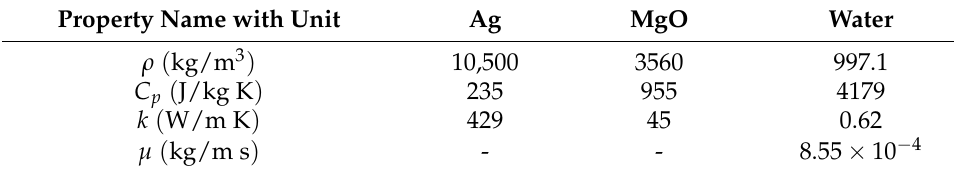
Table 1. Thermophysical properties of hybrid nanoparticles and base fluid [63]. Property Name with